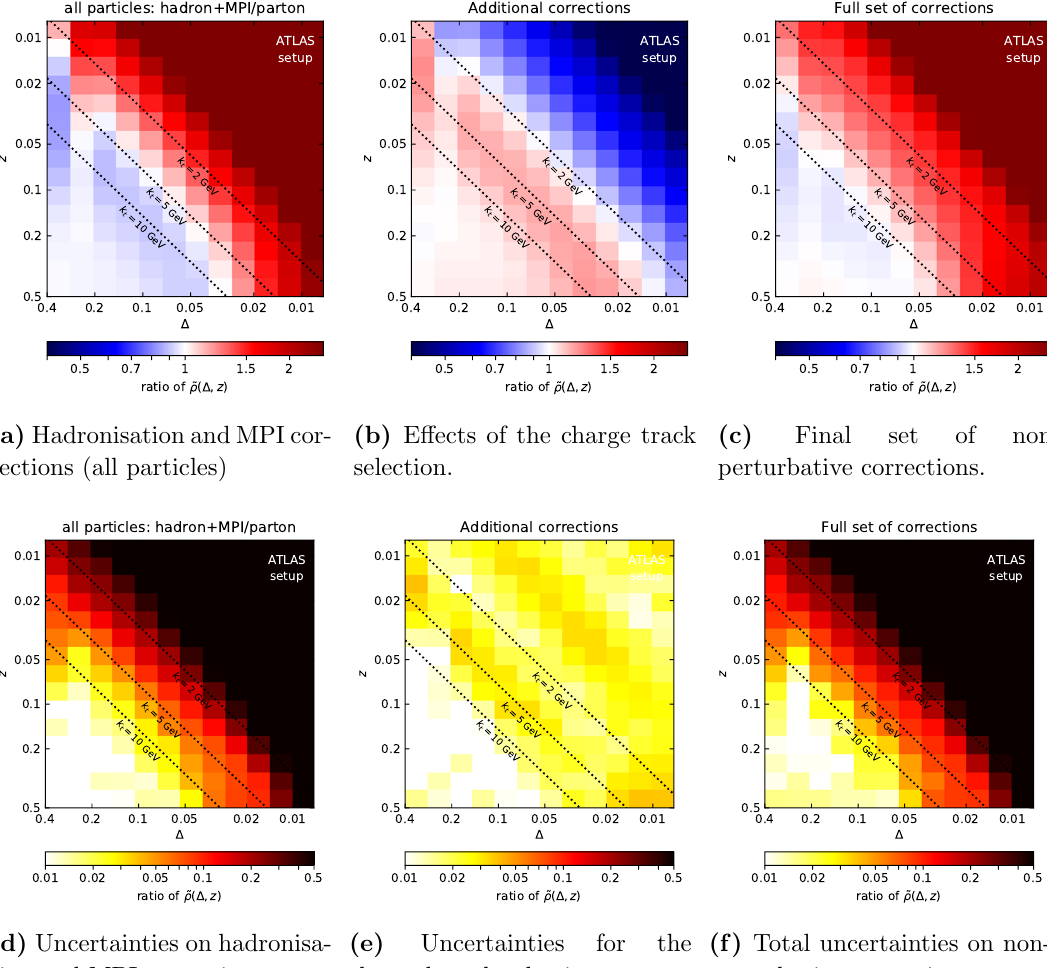
Figure 17. Non-perturbative e(cid:11)ects on ~ (cid:26) ((cid:1) ; z ) for the ATLAS setup. The top row shows the average corrections and the lower row shows the associated